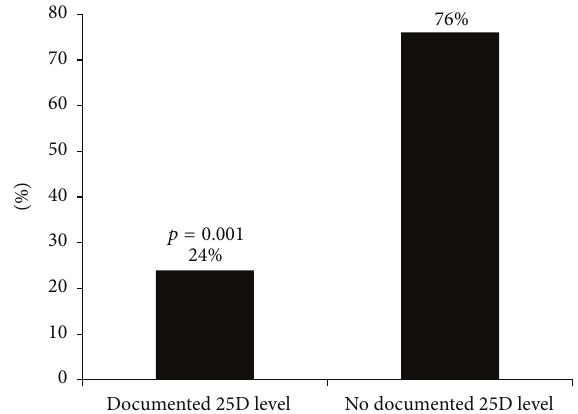
Figure 2: Percentage of subjects on the GFCF diet who had a documented 25(OH)D